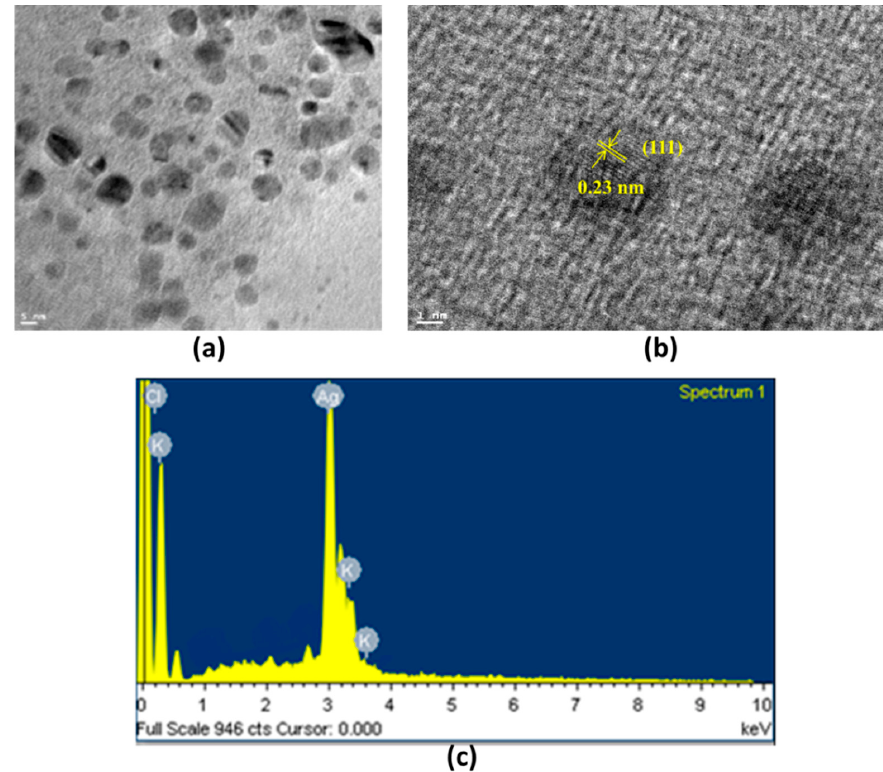
Figure 3. ( a ) TEM analysis of AgNPs indicating the scattered and spherical shapes with an average size of 28.08 nm (Scale bar: 5 nm). ( b ) HRTEM image at 1 nm (100 Å) indicates crystalline formation arrangement in AgNPs. (The lattice spacing 0.23 nm of AgNP (111) plane in high-resolution TEM image). ( c ) Elemental profiling using EDX spectra.